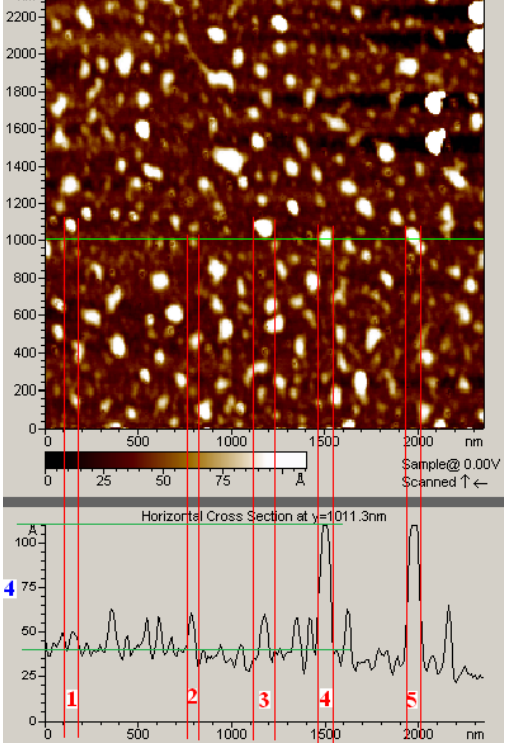
Fig. 2. AFM image of sample A